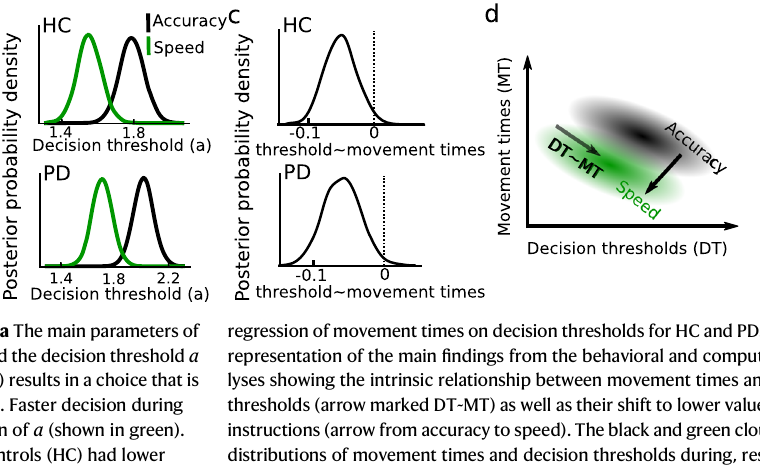
regression ofmovement timeson decisionthresholdsfor HCand PD. D Schematic representation of the main fi ndings from the behavioral and computational ana- lyses showing the intrinsic relationship between movement times and decision thresholds (arrow marked DT~MT) as well astheir shift to lower values after speed instructions(arrowfromaccuracytospeed).Theblackandgreencloudsrepresent distributions of movement times and decision thresholds during, respectively, accuracy and speed